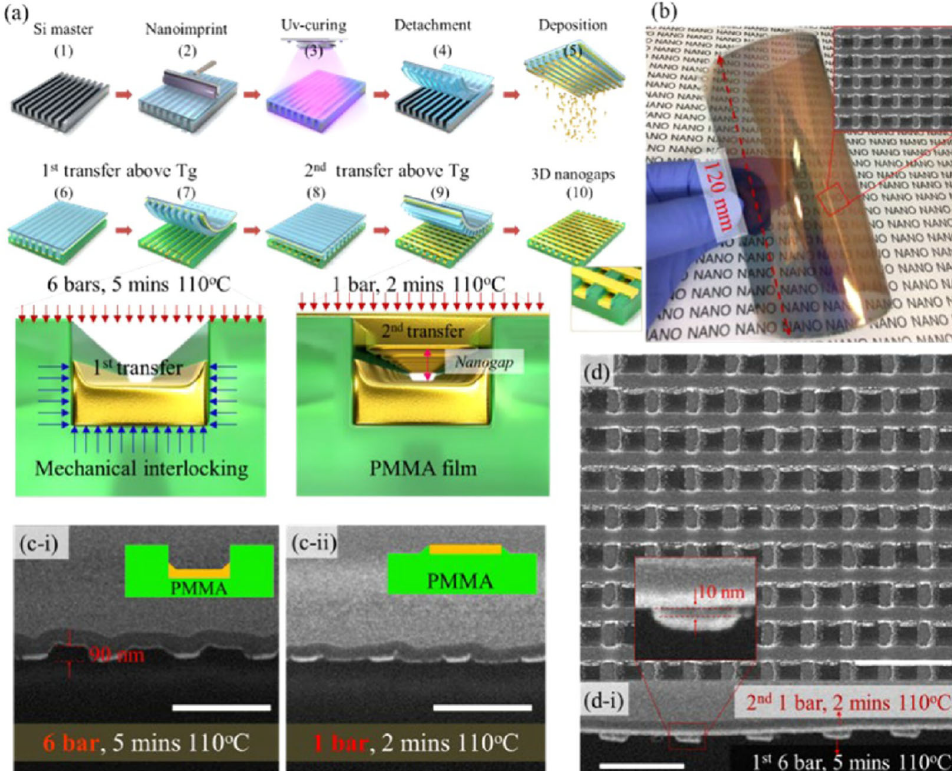
Figure 5. Plasmonic multilaminar nanopores structure and its fabricating process based on Nanoimprint Lithography (NIL). ( a ) The manufacturing process of multilaminar nanopores prepared by NIL. ( b ) The photo of the film with multilaminar nanopores. ( c ‐ i ) and ( c ‐ ii ) The sectional view of multilaminar nanopores manufactured under different conditions. ( d ) SEM image of multilaminar nanopores. Reproduced with permission from reference [59]. Copyright 2021 American Chemical Society.